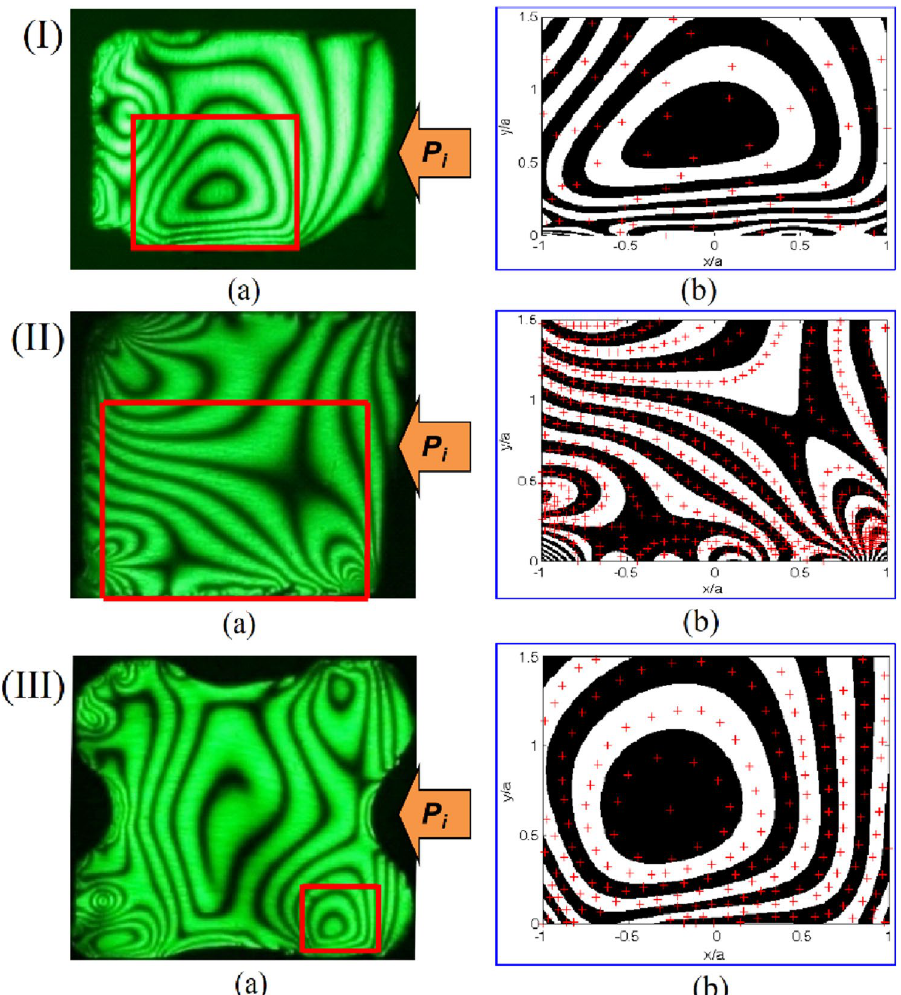
Figure 8. The actual ( a ), and the graphical ( b ) isochromatic fringe patterns on the upper side of; ( I ) D-ring, ( II ) Square ring, and ( III ) X-ring from the photoelastic experimental hybrid method under a uniform compression of 20% and internal pressure ( P i =1